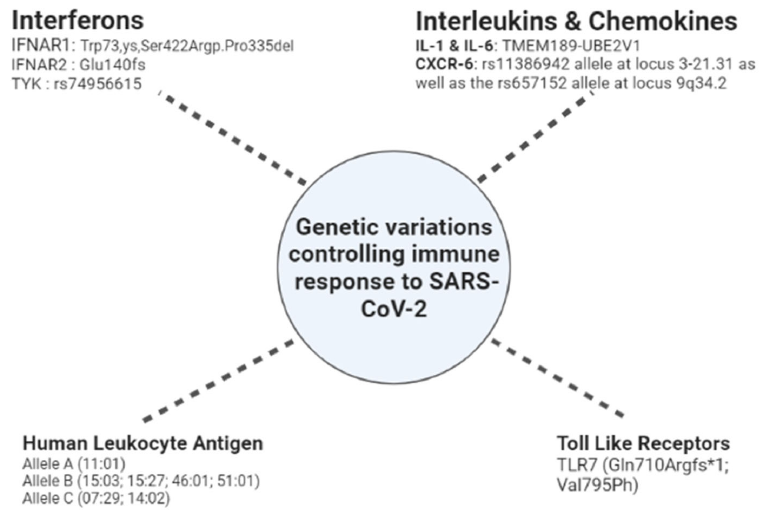
Figure 2. Genetic components responsible for immune